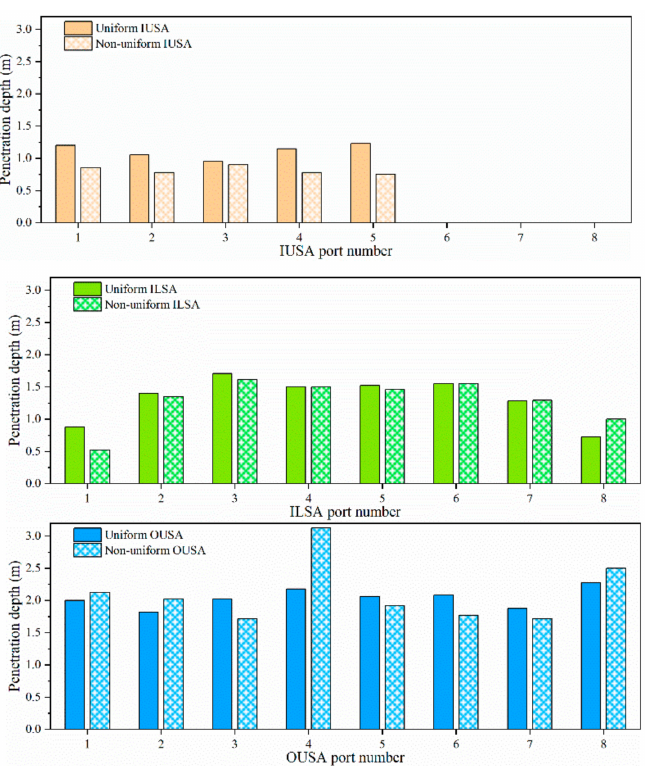
Figure 8. Penetration depths under uniform/non-uniform SA distributions at 100% BMCR load. Table 4. Standard deviations of penetration depth of various SA at 100% BMCR load (unit: m). Working